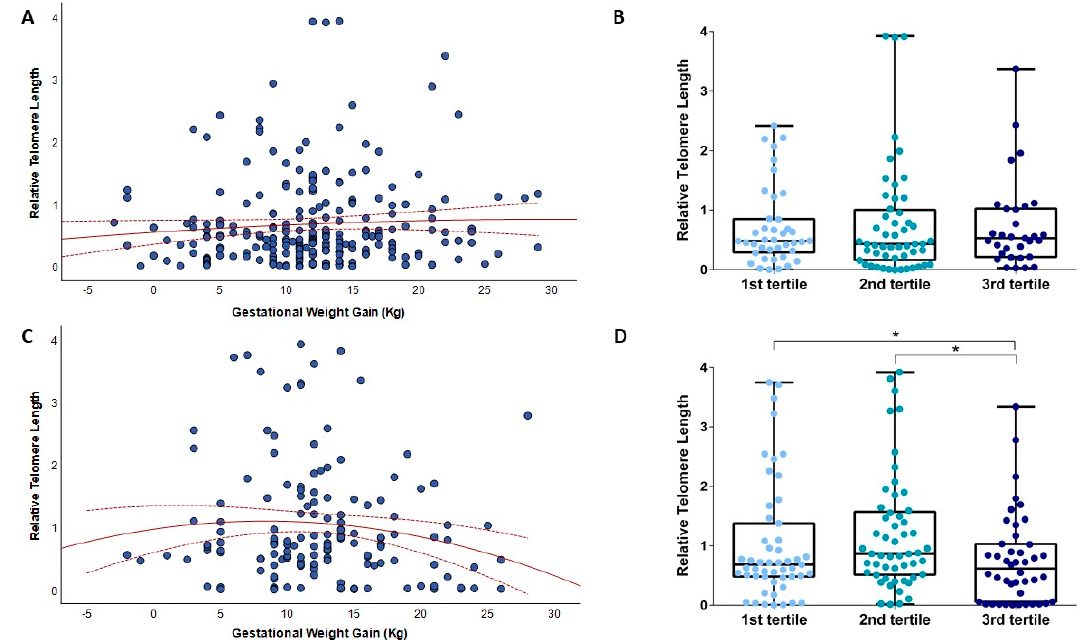
Figure 1. The relationship of gestational weight gain with relative telomere length. ( A ) shows the relationship of gestational weight gain with telomere length of mlDNA; ( B ) shows the box plots of telomere length of mlDNA by the tertile distribution of GWG; ( C ) shows the relationship of gestational weight gain with telomere length of cfDNA from amniotic fluid; ( D ) shows the box plots of telomere length of cfDNA by the tertile distribution of GWG. * p -value < 0.05 based on the Mann–Whitney or Kruskal–Wallis test.